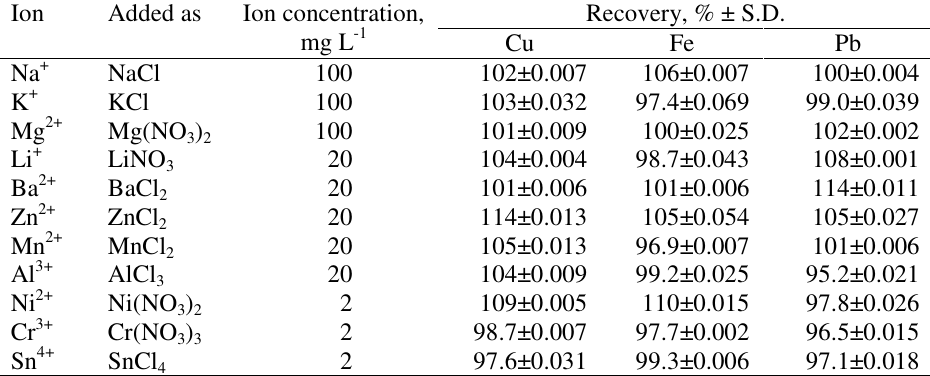
Table 2. Effect of some matrix ions on the recovery of Cu, Fe and Pb ( n = 5)